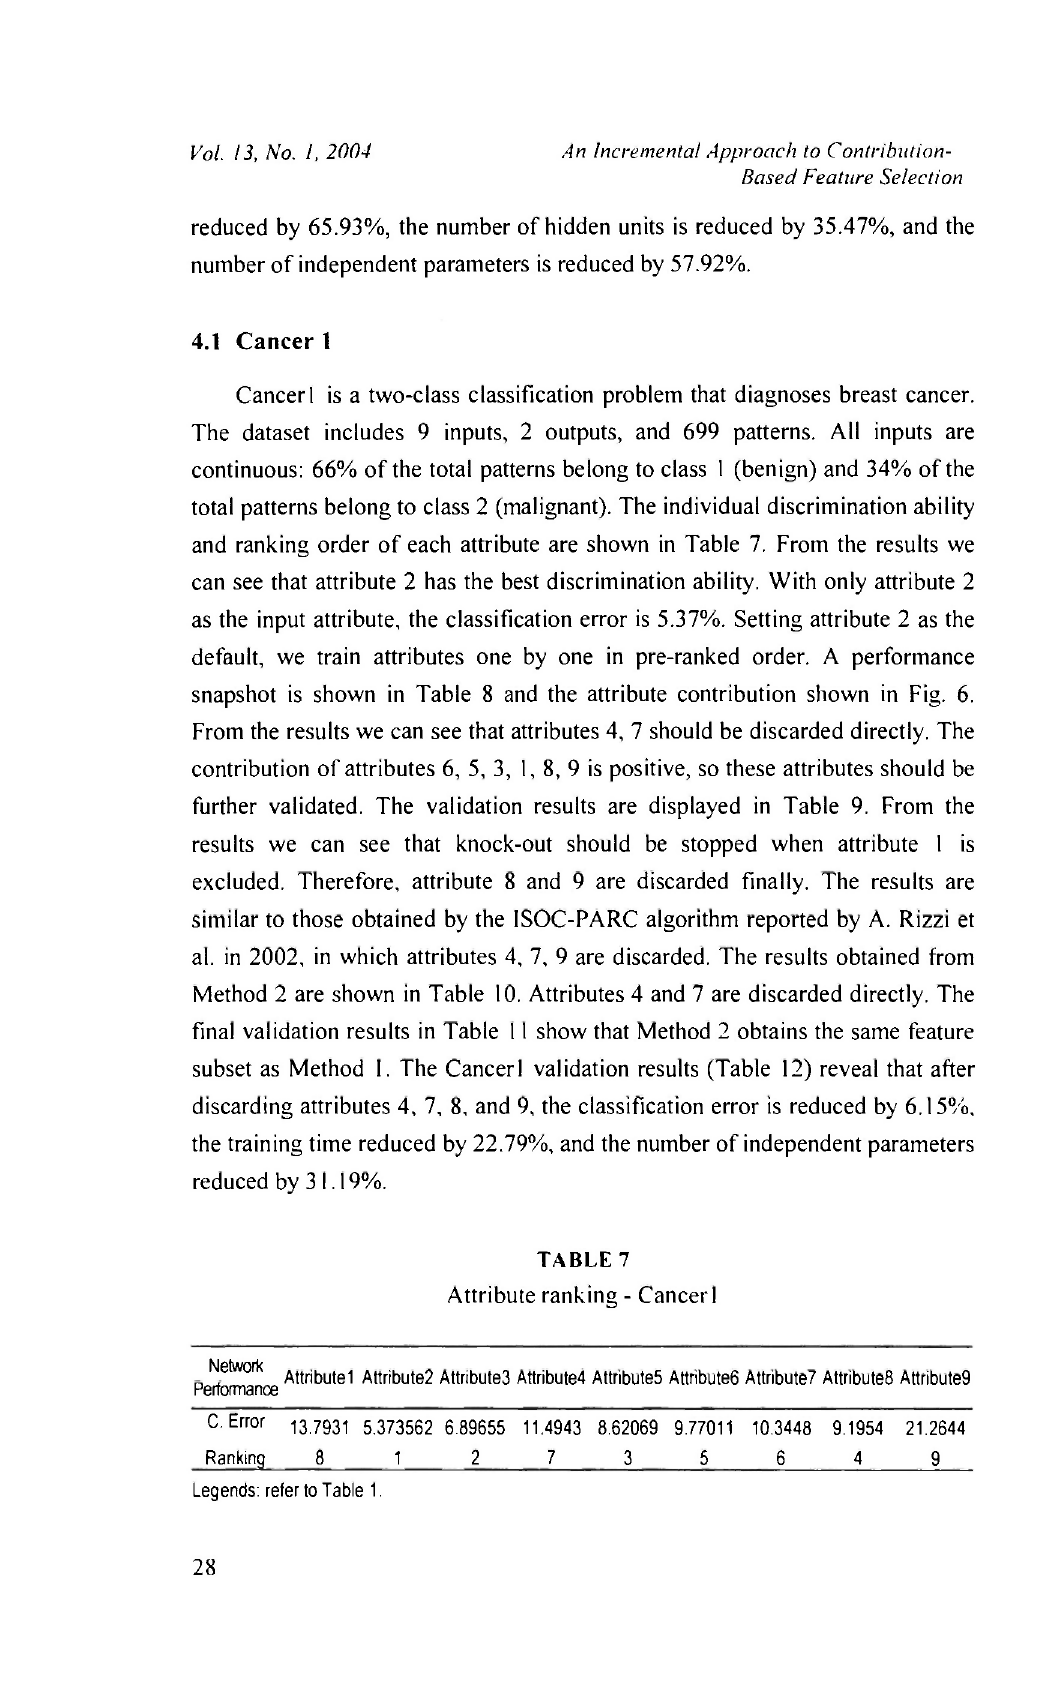
Attribute ranking - Cancerl